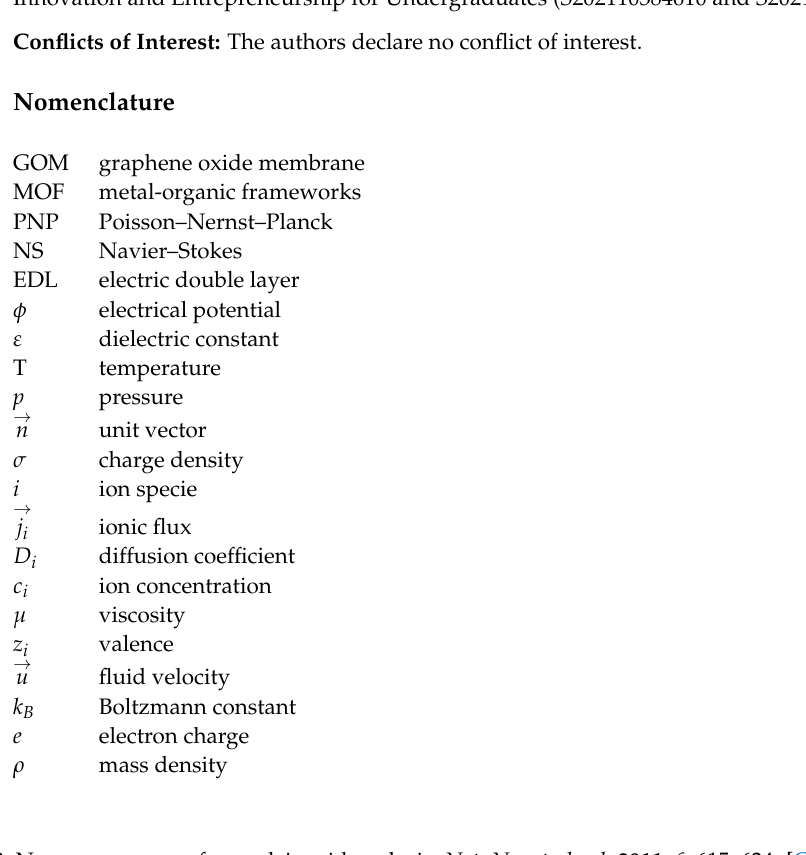
field, Supplementary Figure S3: Different ionic transport responds, Supplementary Figure S4: The distribution of flow velocity, Supplementary Figure S5: The distribution of ionic flux of Ion